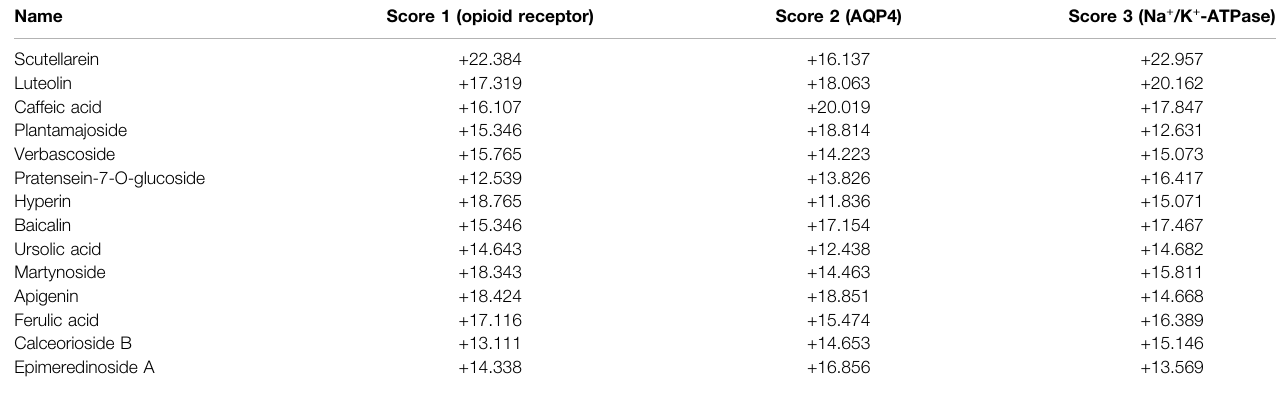
TABLE 3 | Molecular docking scores for 14 components and opioid receptor, AQP4, and Na + /K + -ATPase.